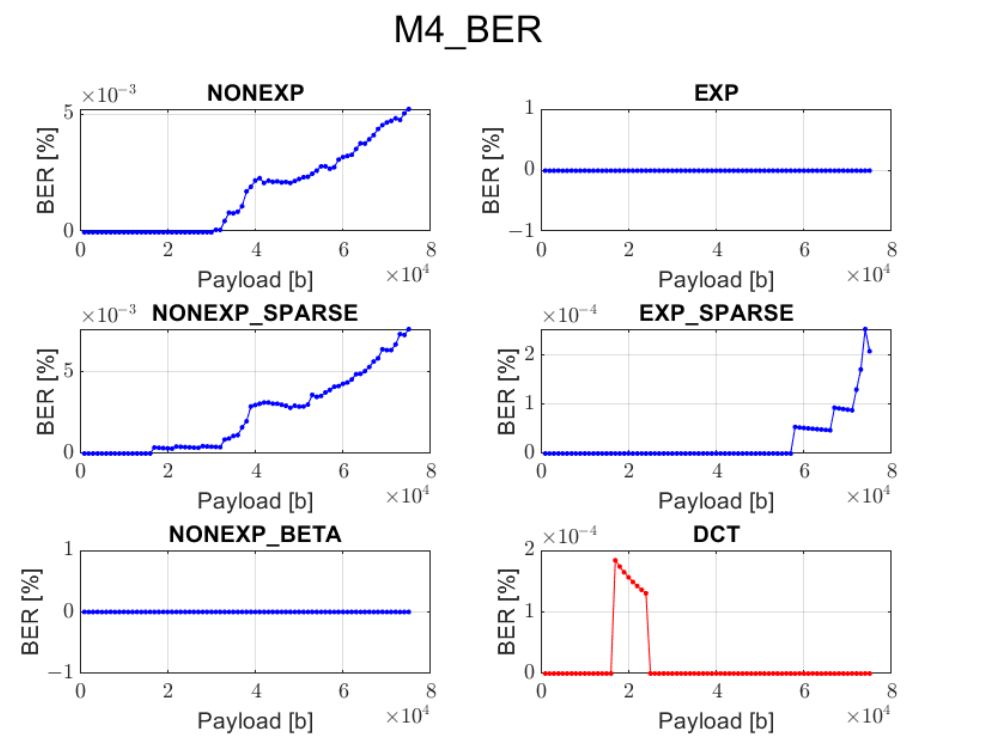
Figure 10. Relation between BER and embedded data size for method 4 and all transform types.